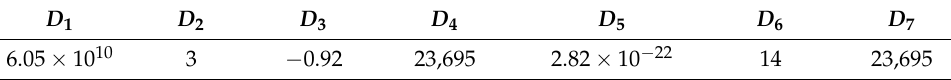
Table 1. Material coefficients for combined time hardening law, where stress is expressed in MPa, time in s, and temperature in K